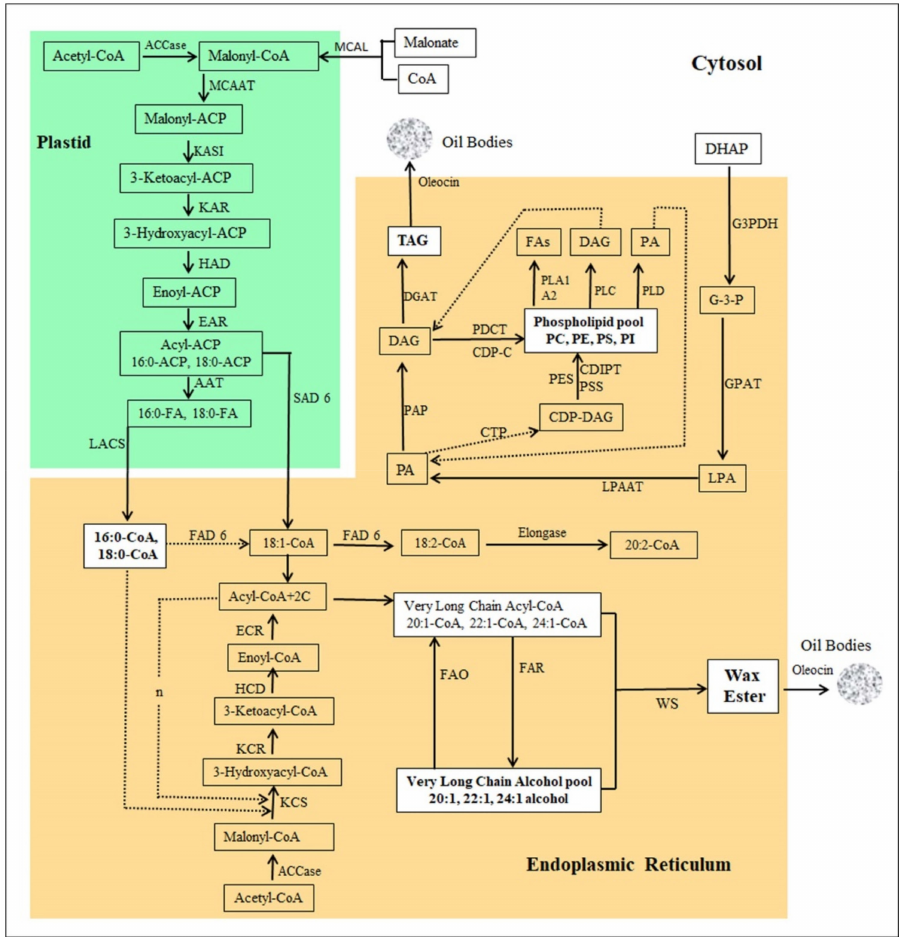
Figure 7. Pathway of Jojoba wax ester biosynthesis. MCAL: malonate-CoA ligase, ACC: acetyl-CoA carboxylase, MCAAT: malonyl-CoA acyl carrier protein (ACP) transacylase, ACAT: acetyl-CoA:ACP acetyltransferase, KASI: 3-ketoacyl-ACP synthase I, KAR: 3-ketoacyl-ACP reductase, HAD: 3-hydroxyacyl-ACP dehydratase, EAR: enoyl-ACP reductase, AAT: acyl-ACP thioesterase, LACS: long chain acyl-CoA synthase, KCS: 3-ketoacyl-CoA synthase (Elongase), KCR: 3-ketoacyl-CoA reductase, HCD: 3-hydroxyacyl-CoA dehydratase, ECR: enoyl-CoA reductase, SAD6: stearoyl-[acyl-carrier-protein] 9-desaturase, FAD6: omega-6 fatty acid desaturase, FAR: fatty acyl-CoA reductase, FAO: fatty alcohol oxidase, WS: wax ester synthase, elongase, G3PDH: glycerol-3-phosphate dehydrogenase, GPAT: glycerol-3-phosphate acyltransferase, LPAAT: 1-acyl-sn-glycerol-3-phosphate acyltransferase, PAP: phosphatidate phosphatase, DGAT: diacylglycerol O-acyltransferase, CTP: phosphatidate cytidylyltransferase, CDIPT: CDP-diacylglycerol–inositol 3-phosphatidyltransferase, PSS: CDP-diacylglycerol-serine O-phosphatidyltransferase, PES: N-acylphosphatidylethanolamine synthase, PDCT: phosphatidylcholine: diacylglycerol cholinephosphotransferase, PLA1: phospholipase A1, PLA2: phospholipase A2, PLC: phospholipase C, PLD: phospholipase D, DHAP: dihydroxyacetone phosphate, G3P: glyceraldehyde 3-phosphate, LPA: lysophosphatidic acid, PA: phosphatidic acid, DAG: diacylglycerol, TAG: triglycerides, CDP-DAG: CDP-diacylglycerol. CDP-C: